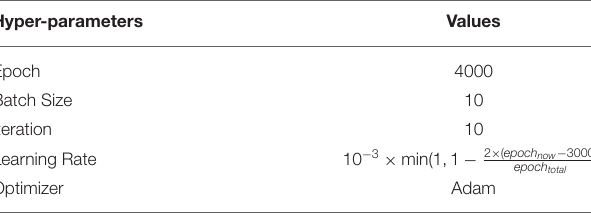
TABLE 2 | Hyper-parameters of the second task.